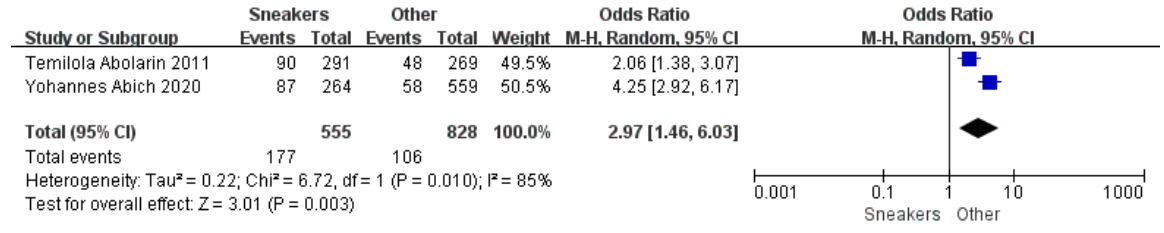
Figure 6. The forest plot of shoe shape for flatfoot in children [11,20].